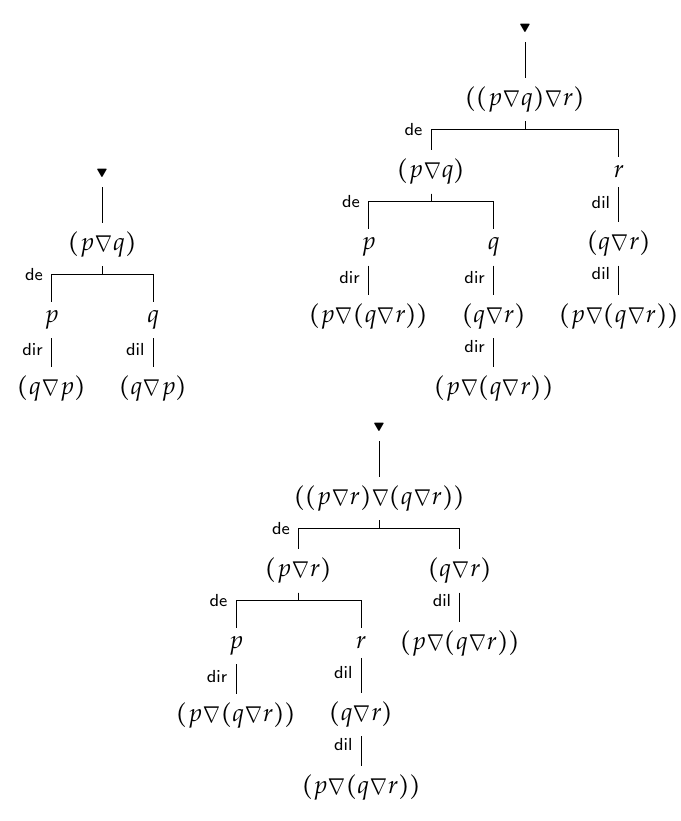
Figure 12. Proof of ( DC ) , ( DRA ) , ( DD )